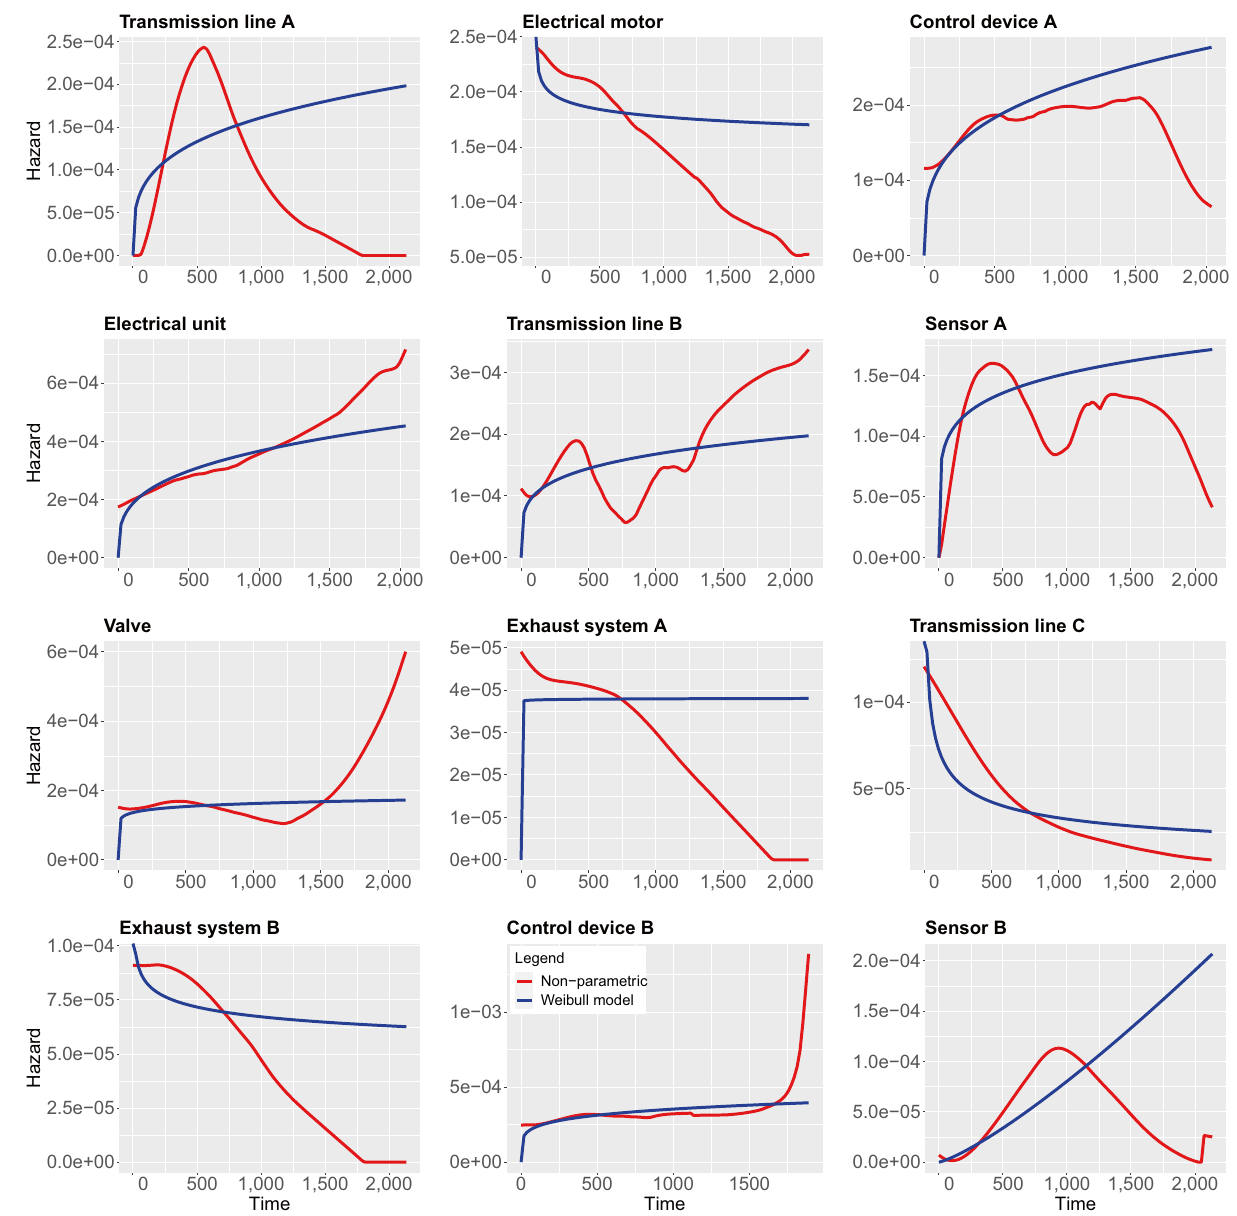
Figure 7. Weibull model hazard. Blue curve indicates Weibull model hazard and red curve represents non- parametric kernel-estimator